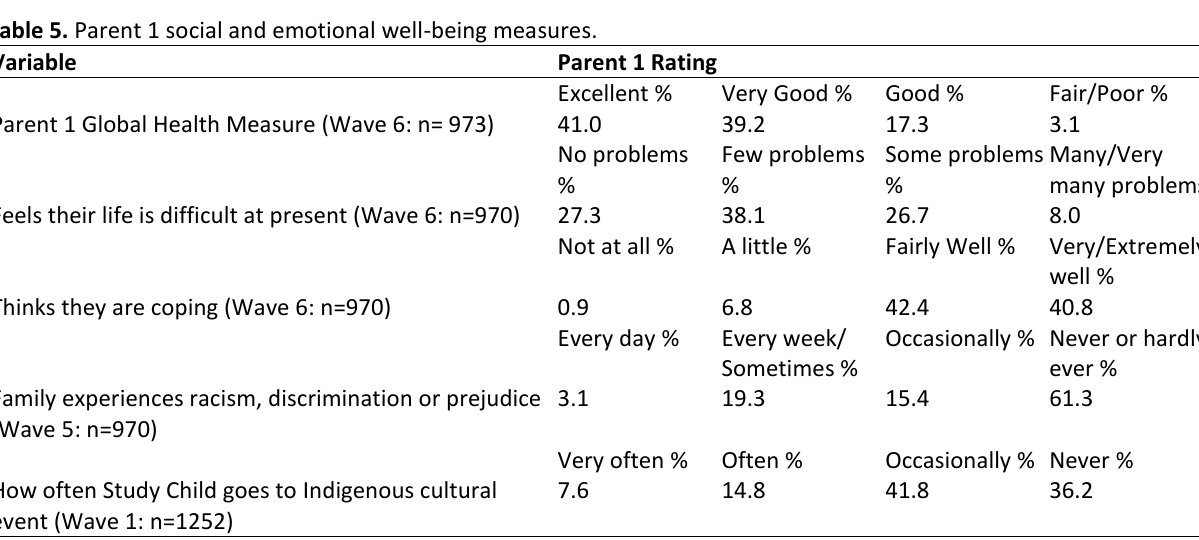
Table 5. Parent 1 social and emotional well-being measures.